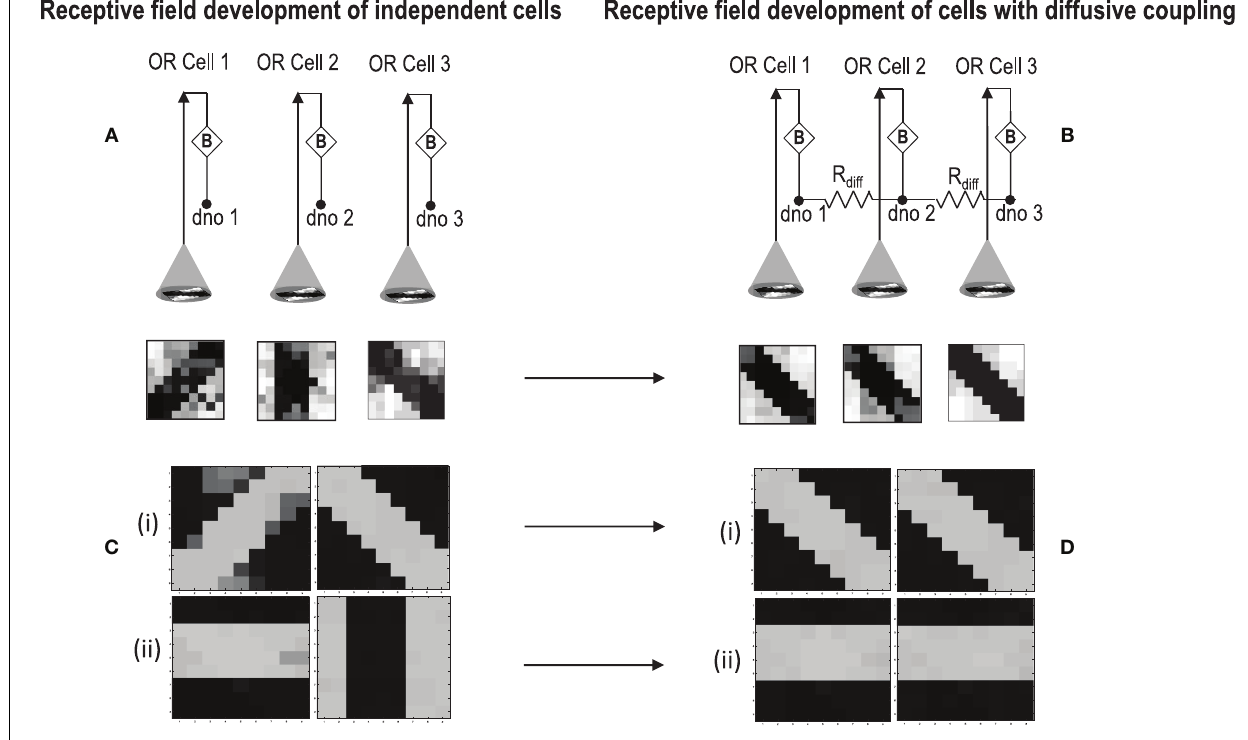
FIGURE 12 | (A) Shows the independent development of receptive fields of three orientation selective cells with different initial biases and same random inside epoch order of inputs. (B) Shows the development of the same three cells with the initial conditions and order of inputs same as (A) , but with diffusive interaction between neighbors. All the cells develop similar feature